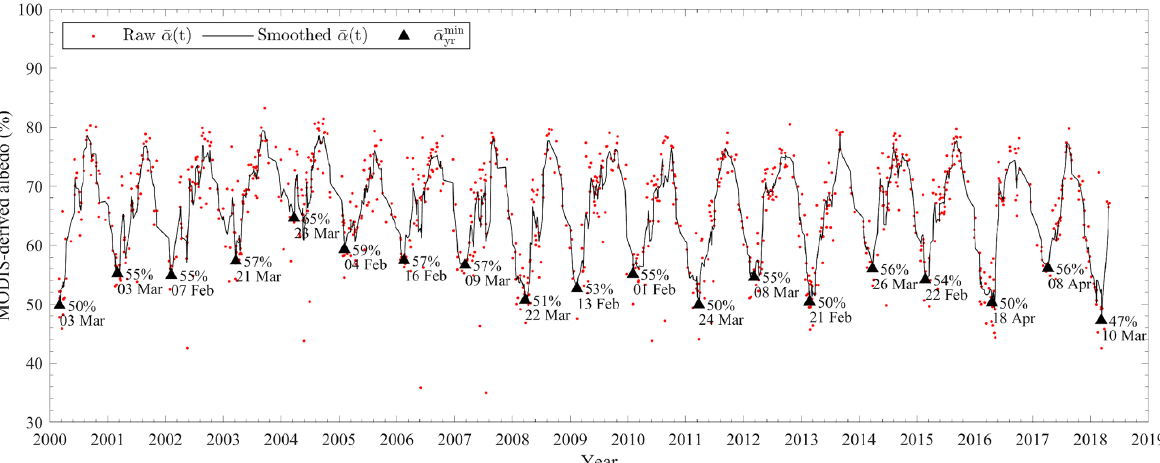
Figure 8. Near-daily MODIS-derived glacier-wide surface albedo ¯ α(t ) on Lambert Glacier between February 2000 and April 2018, with the three-period rolling average and annual minimum glacier-wide albedo ¯ α min yr indicated in black.